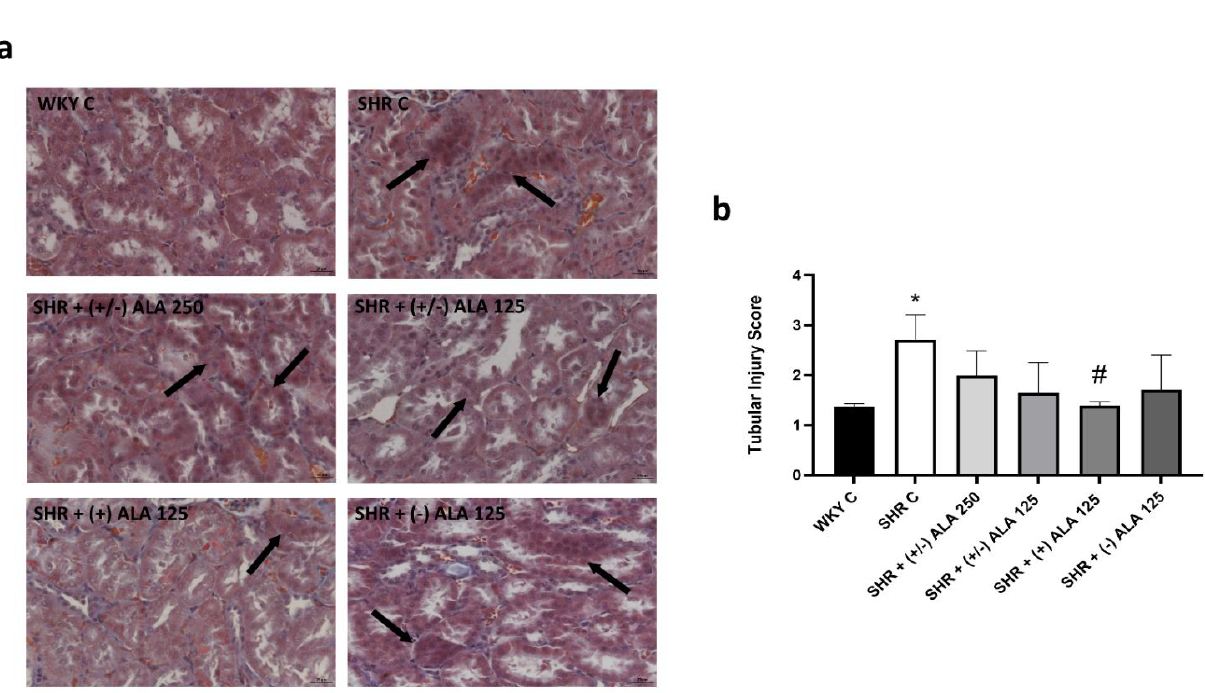
Figure 4. Renal glomerular morphology. ( a ) Renal tissue of WKY C, SHR C, SHR + (+/ − ) alpha lipoic acid (ALA) 250 µmol/kg/day, SHR + (+/ − ) ALA 125 µmol/kg/day, SHR + (+) ALA 125 µmol/kg/day, SHR + ( − ) ALA 125 µmol/kg/day were stained using Masson’s trichrome technique. Arrow: damaged glomerulus. Calibration bar: 50 µm; ( b ) Morphometric analysis to assess the glomerular injury score. Data are mean ± S.E.M. * p < 0.05 vs. WKY C; # p < 0.05 vs. SHR C.